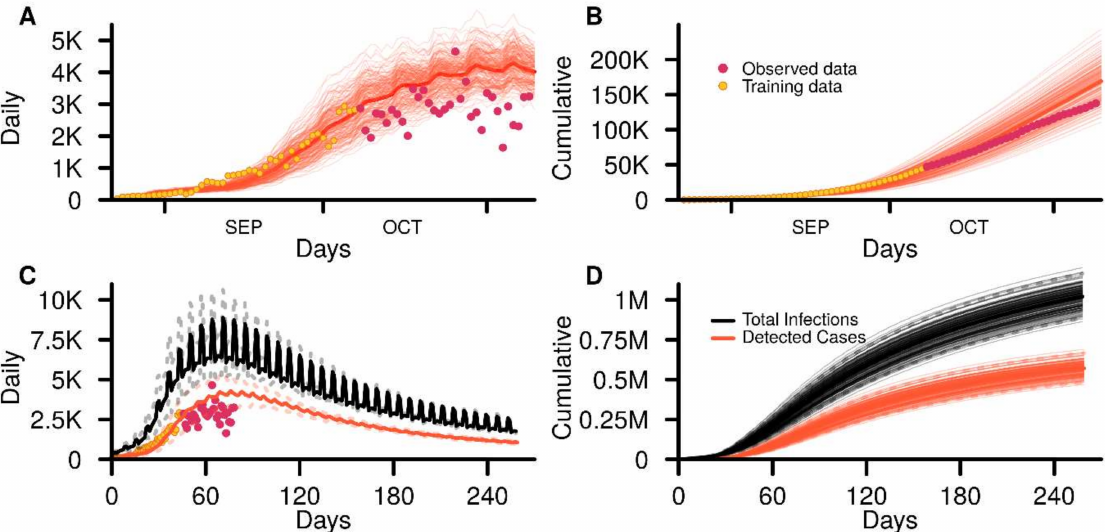
Figure 2. GeoDEMOS-R baseline outputs from 200 simulations. ( A ) Daily and ( B ) cumulative detected cases for the initial 90 days of baseline simulations. ( C ) Daily and ( D ) cumulative infections and detected cases for the entire 250 days of baseline simulations. Dashed lines represent the 95% interval.